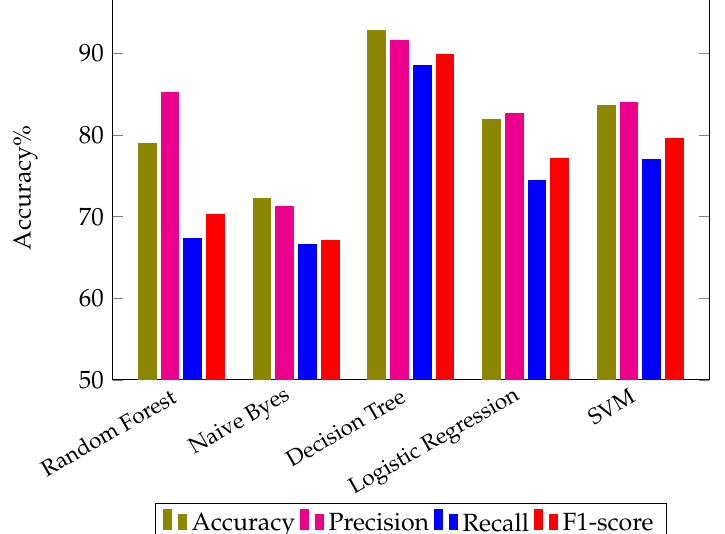
Figure 9. Machine learning Performance on Sinovac dataset.